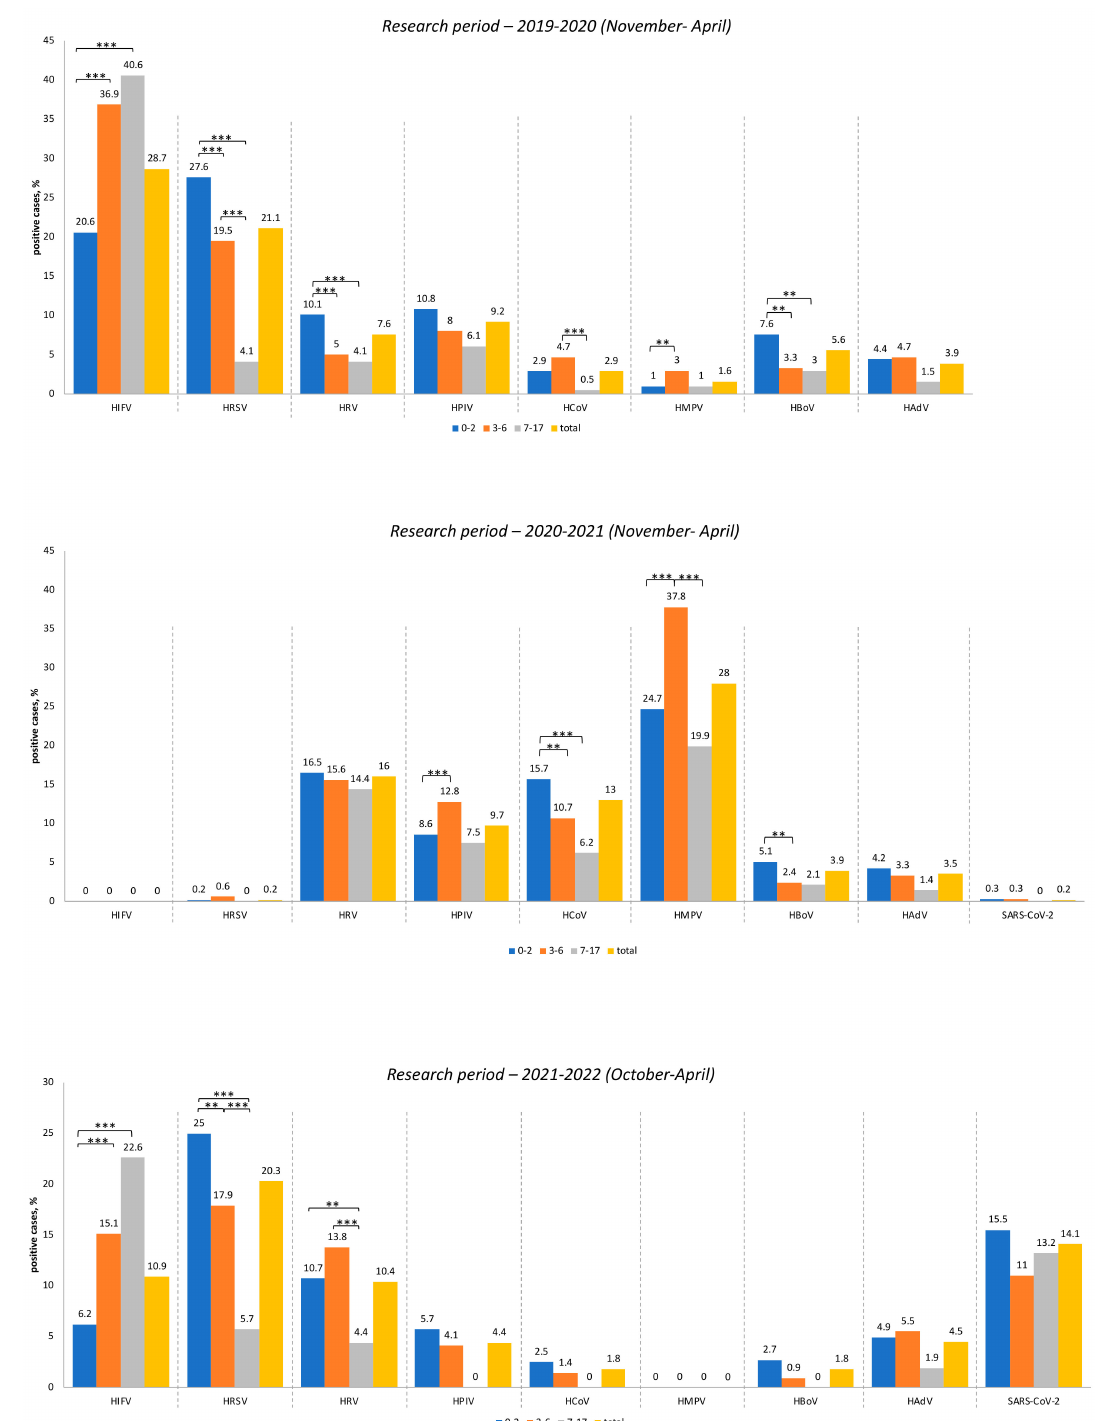
Figure 2. Viral load among various child age groups between 2019 and 2022. All data are presented as a percentage of the positive cases relative to the total number of PCR-confirmed